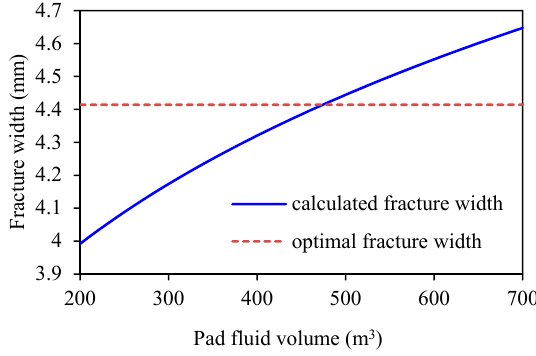
Figure 7. Curves of propped fracture width vs. pad fluid volume for the first adjusted design.